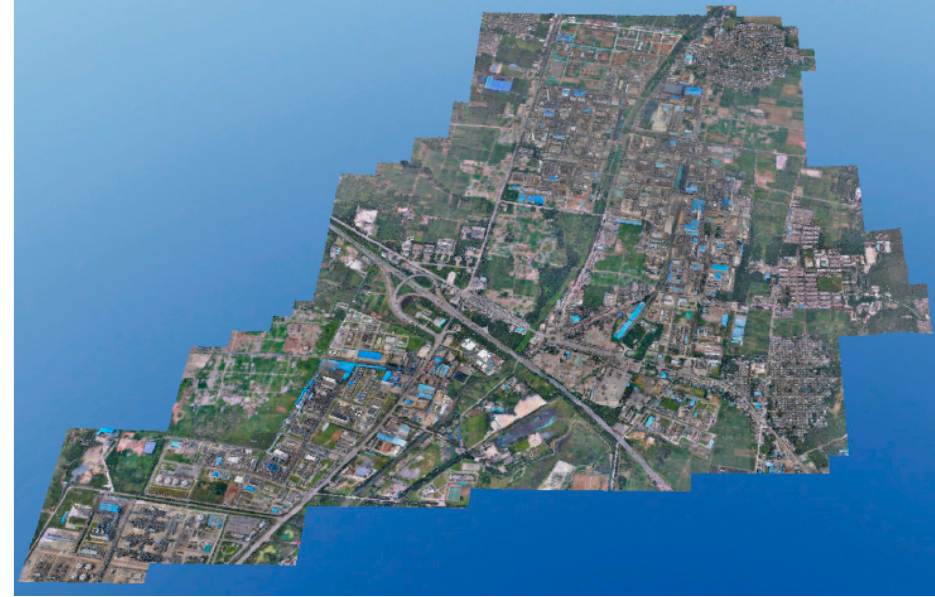
Figure 10. Experimental